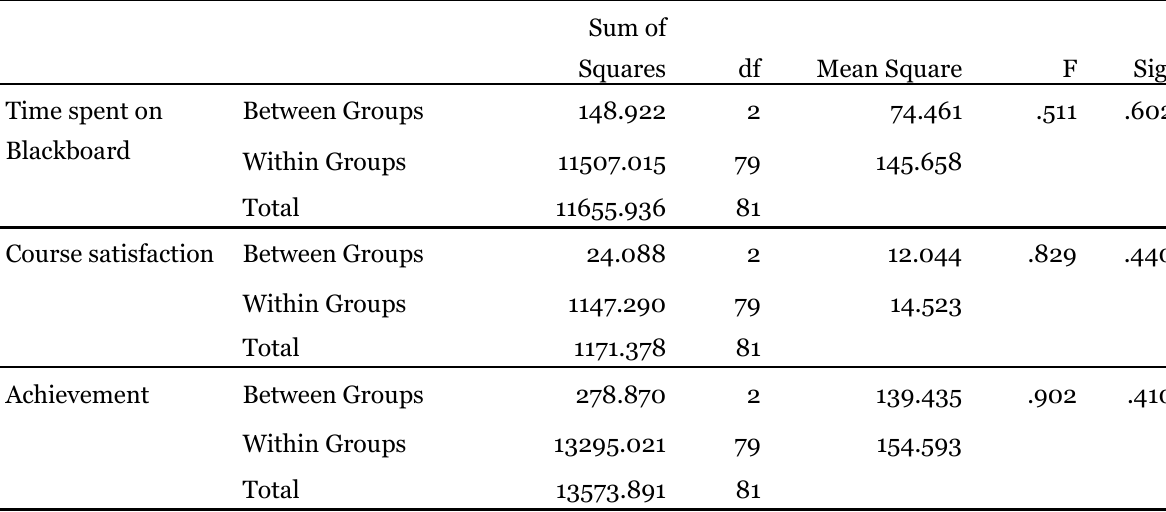
ANOVA Results for Time Spent on Blackboard, Course Satisfaction, and Achievement Between Discussion